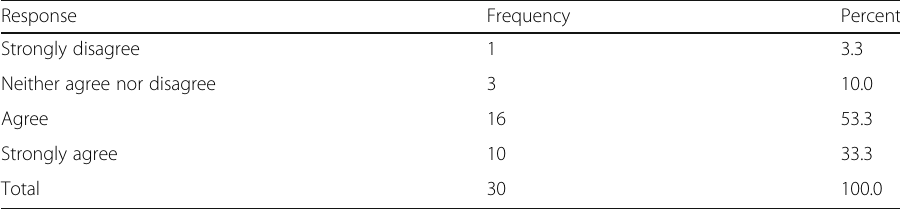
Table 4 Formation of powerful policies useful in decongestion process Response Frequency Percent Strongly disagree